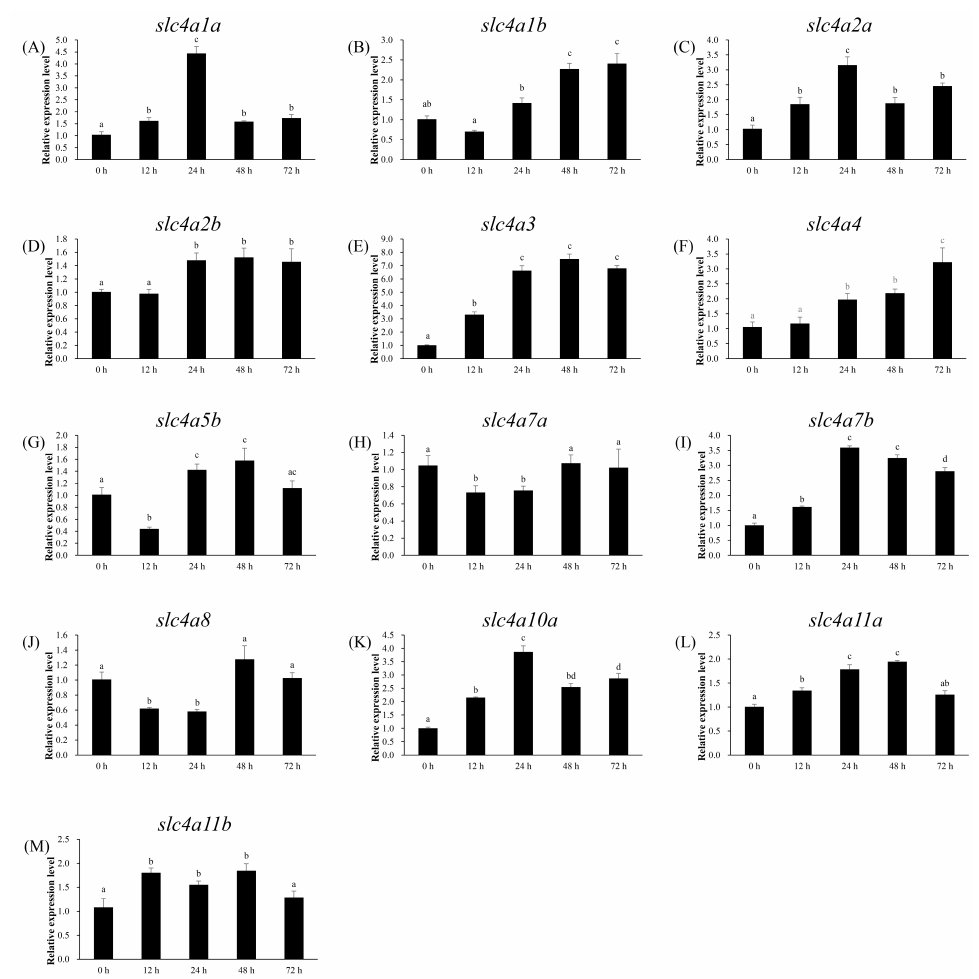
Figure7. Expressionof slc4 genesingillofspottedseabassafteralkalinitystress. ( A – M ): slc4a1a – slc4a11b . Figure 7. Expression of slc4 genes in gill of spotted sea bass after alkalinity stress. ( A – M ): slc4a1a – Significant di ff erences ( p < 0.05) were indicated with di ff erent slc4a11b . Significant differences ( p < 0.05) were indicated with different letters.